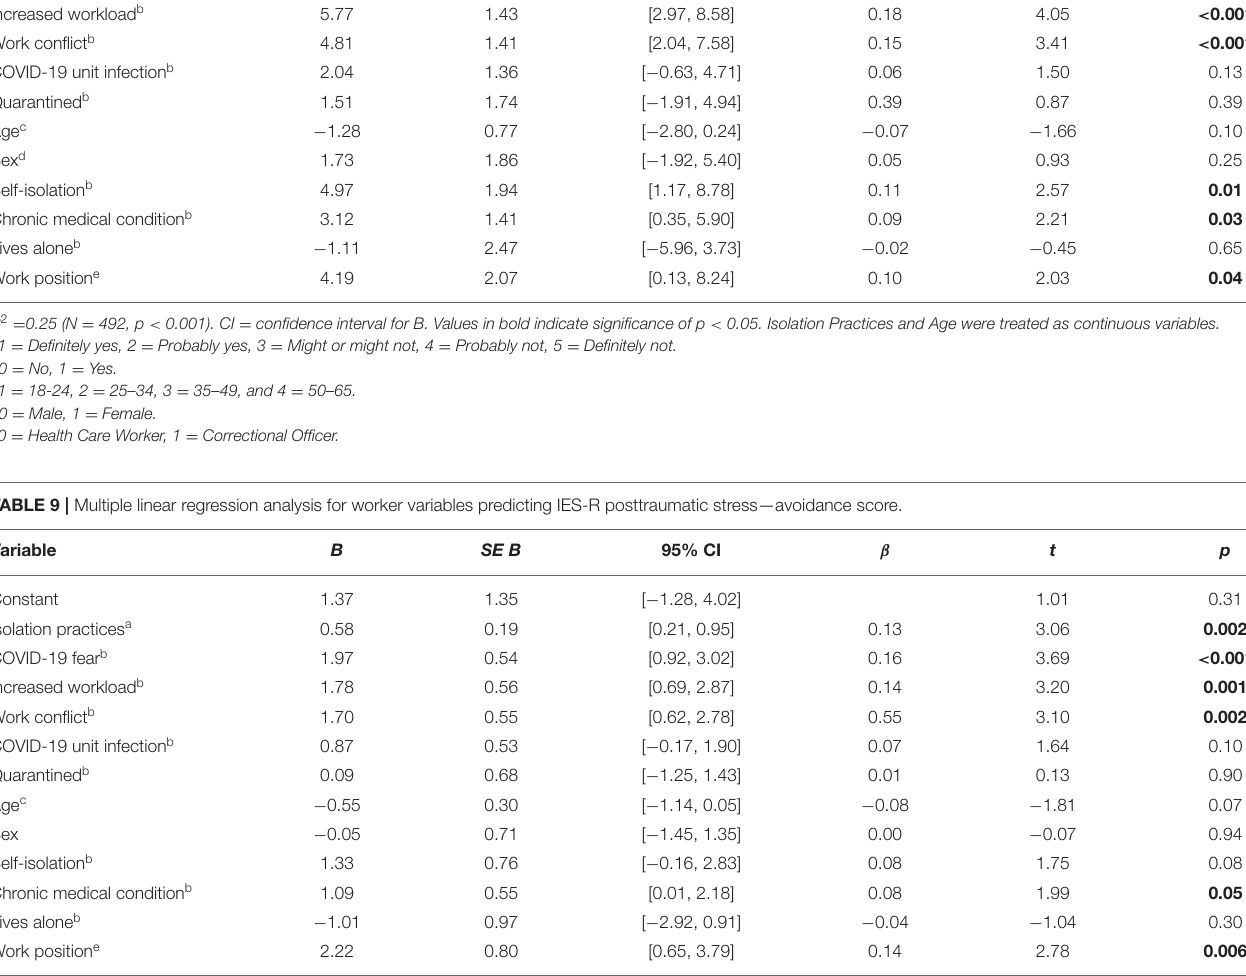
TABLE 8 | Multiple linear regression analysis for worker variables predicting IES-R posttraumatic stress total score. Variable B SE B 95% CI β t p Constant